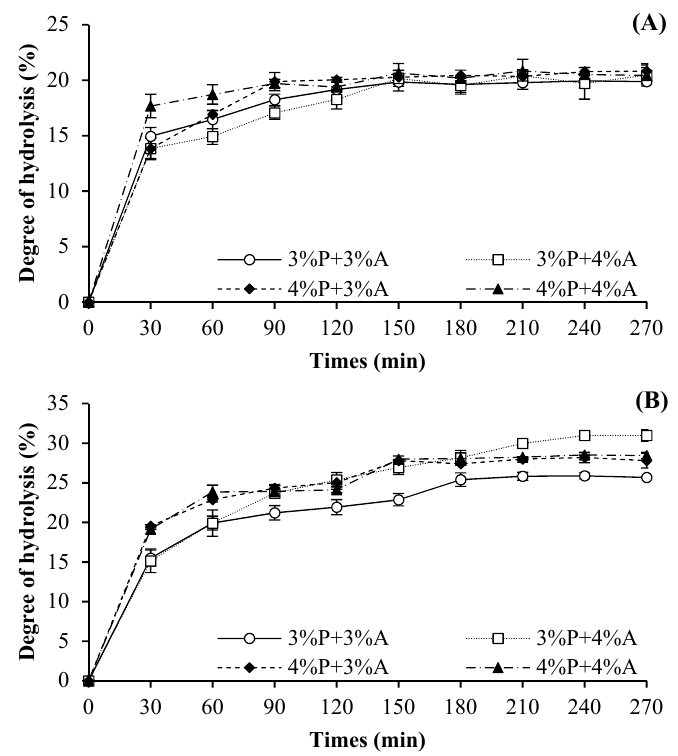
Figure 1. Degree of hydrolysis (DH) curve of hydrolyzed collagen (HC) from salmon skin prepared using mixed proteases at different concentrations at pH 7.0 ( A ) and 8.0 ( B ). P: papain; A: Alcalase. Bars represent the standard deviation ( n = 3).